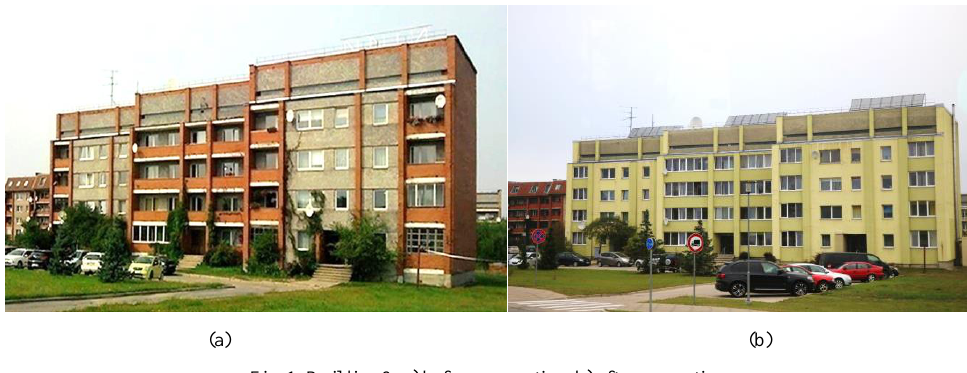
Fig. 1. Building 3: a) before renovation; b) after